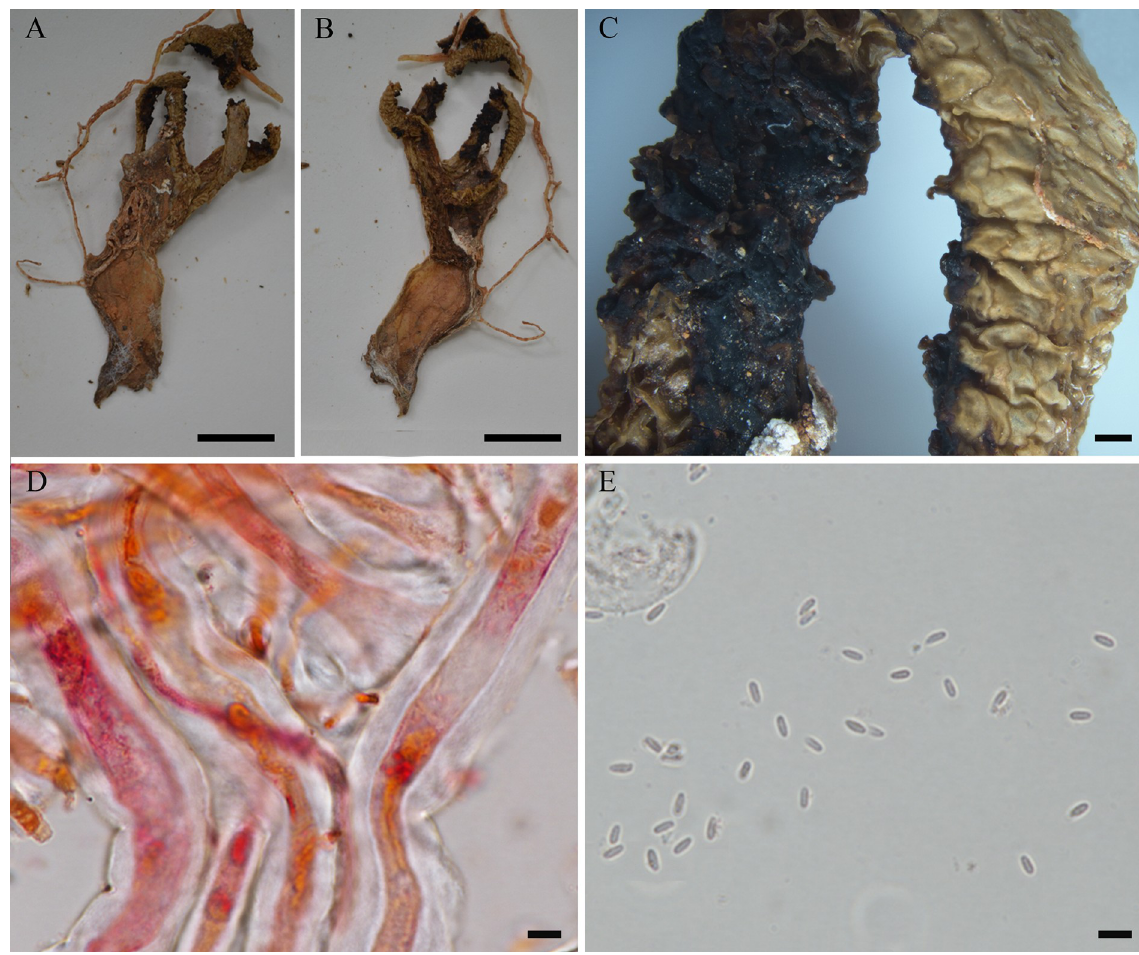
Fig 11. Blumenavia usambarensis , B 700016468, holotype. (A, B) Dry basidiomata. (C) Arm edge and glebifer. (D) Rhizomorph hyphae in 1% Congo red. (E) Basidiospores in 5% KOH. (A, B) bar = 10 mm; (C) bar = 1 mm; (D–E) = 5 μ m.